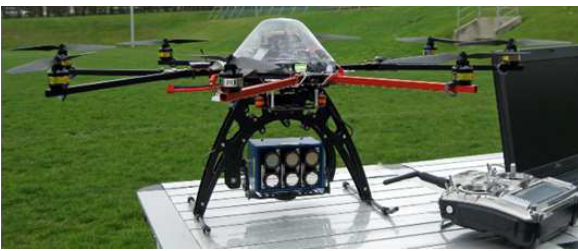
Figure 1: MikroKopter Oktokopter with mounted mini-MCA Multispectral Sensor (Photo: Darren Turner)